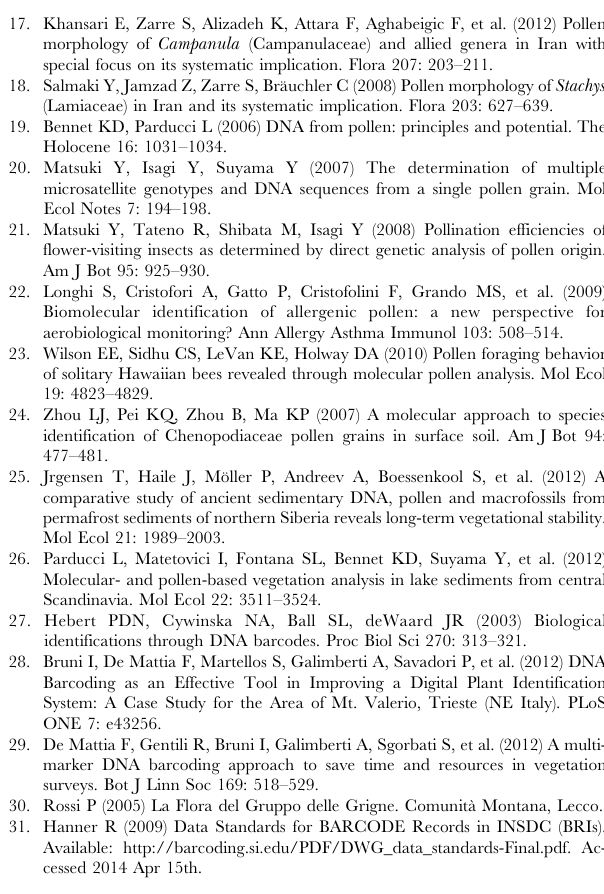
Figure S1 Pollen collection system. To collect pollen pellets, two modified beehives (a) for each sampling locality have been equipped with grids (c) for scraping some of the pollen from the corbicula of entering honeybees. Pellets fall into a tray where they can be easily collected at the designed sampling dates (b).